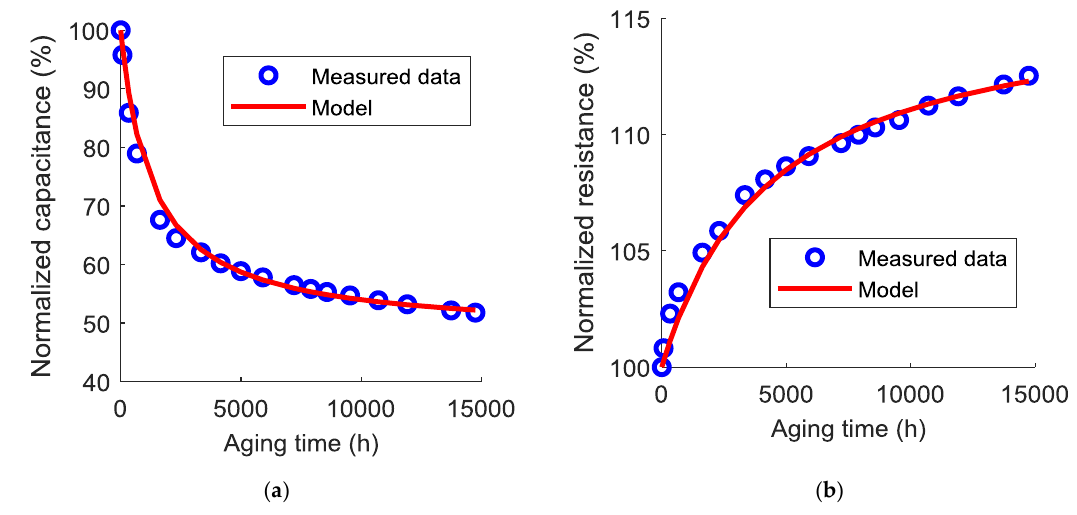
Figure 8. Comparison between the measured data and the model for the capacitance ( a ) and the equivalent series resistance ( b ) evolutions at 60 °C.